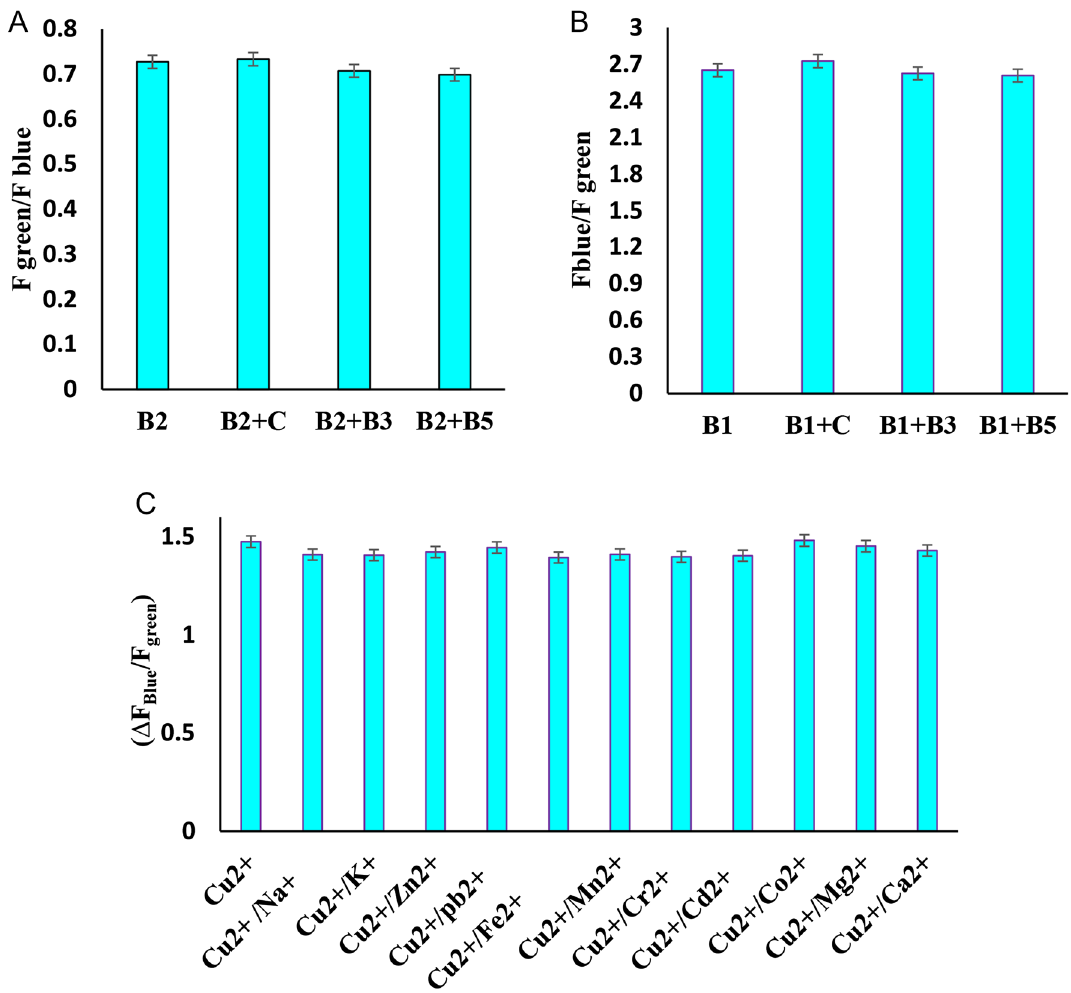
Figure 6. Selectivity studies of the Zn/Cl-CQDs nanosensor ( A ) The fluorescence intensity of the Zn/Cl-CQDs sensing system for riboflavin (500 nM) in the presence and absence of different interfere Vitamins C, B3, B5 with concentration of 5000 nM. ( B ) The fluorescence intensity of the Zn/Cl-CQDs sensing system for thiamine (0.16 µM) in the absence and presence of different interfere other vitamins (C, B3, B5) with concentration of 1.6 µM. ( C ) Change in fluorescence intensity of the Zn/Cl-CQDs sensing system for Cu 2+ (32.5 µM) in the absence and presence of different interfere ions (including Na + , K + , Zn 2+ , Pb 2+ , Fe 2+ , Mn 2+ , Cr 2+ , Cd 2+ , Co 2+ , Mg 2+ , Ca 2+ ) with concentration of 325